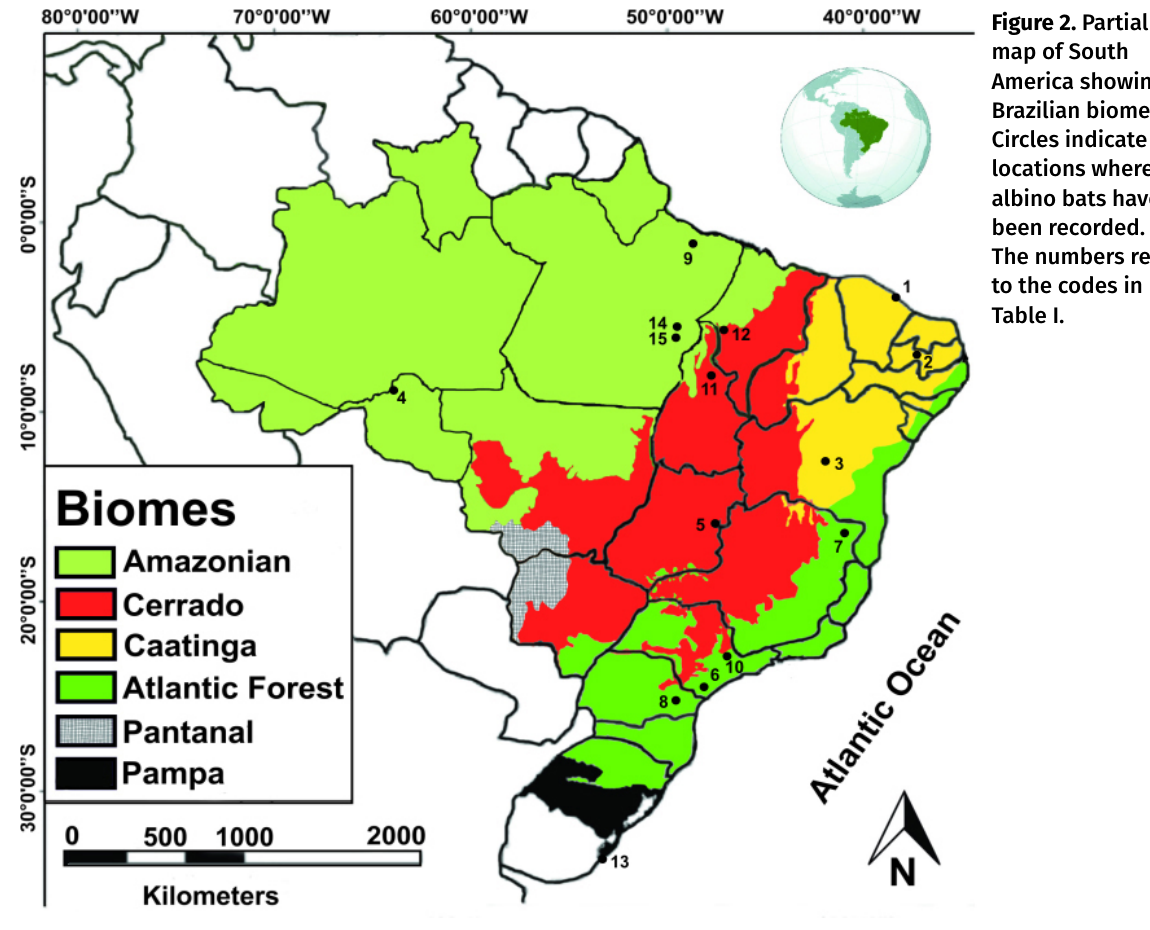
Figure 2. Partial map of South America showing Brazilian biomes. Circles indicate locations where albino bats have been